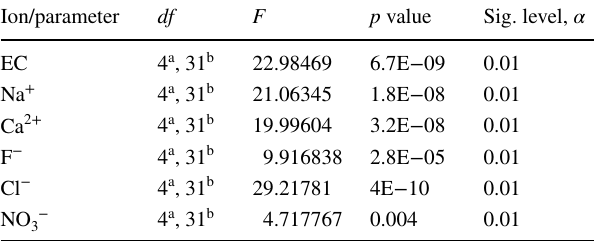
Table 5 One-way ANOVA, single-factor results comparing water clusters